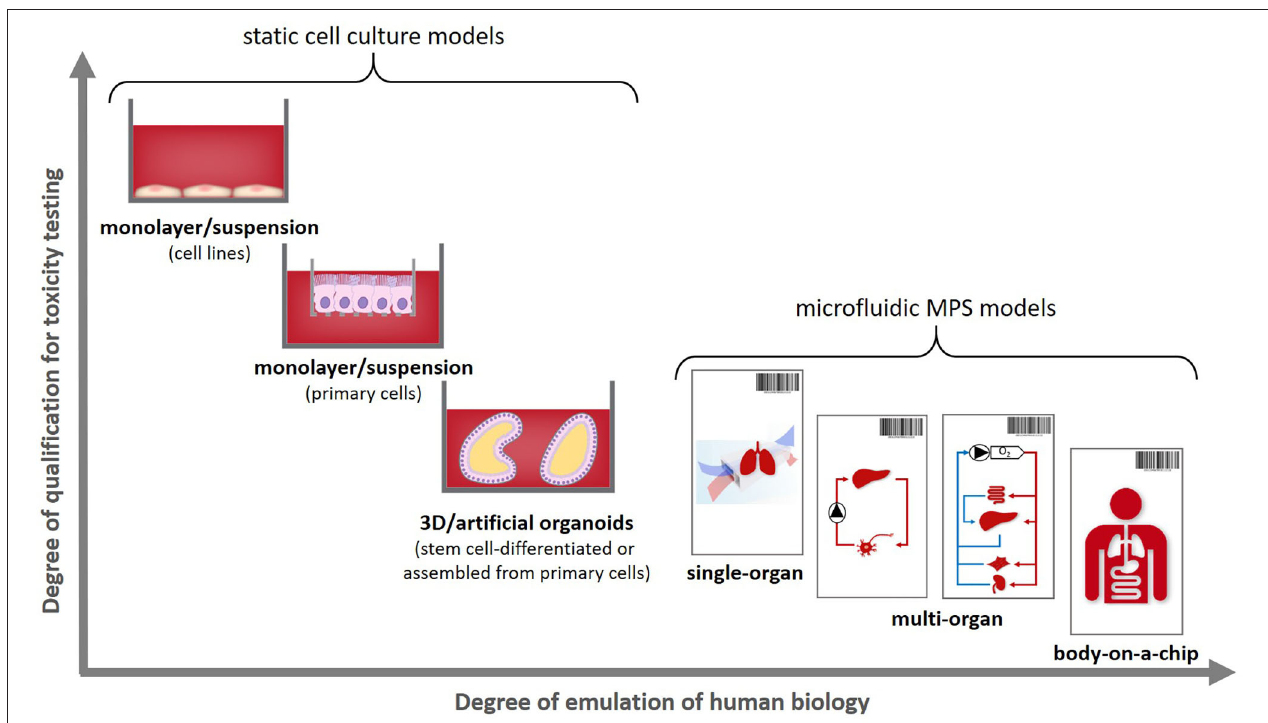
FIGURE 2 | Positioning human organismoids—body-on-a-chip equivalents—within the current cell model landscape [adopted from